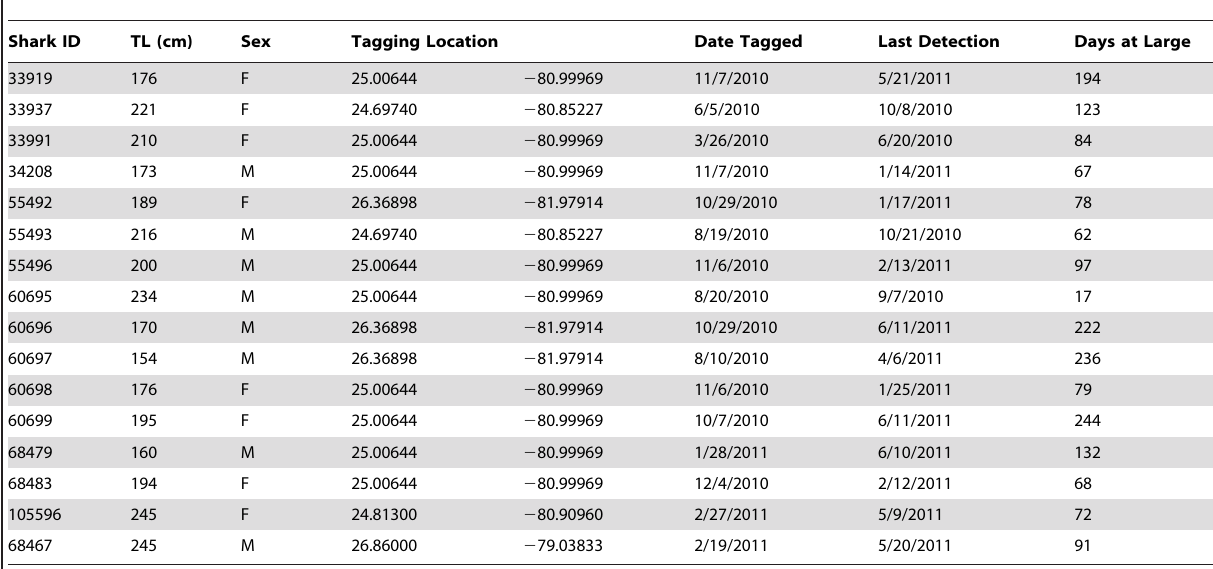
Table 1. Summary data for 16 bull sharks tracked with SPOT5 tags. TL =Total